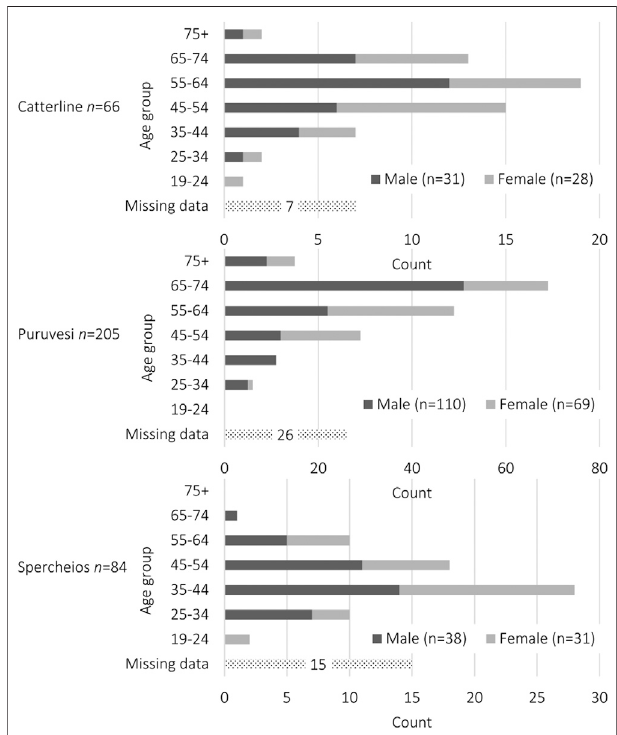
FIGURE 2 | Distribution of male and female respondents in the three study sites by age group. Respondents were explicitly instructed to skip this survey item if they preferred not to